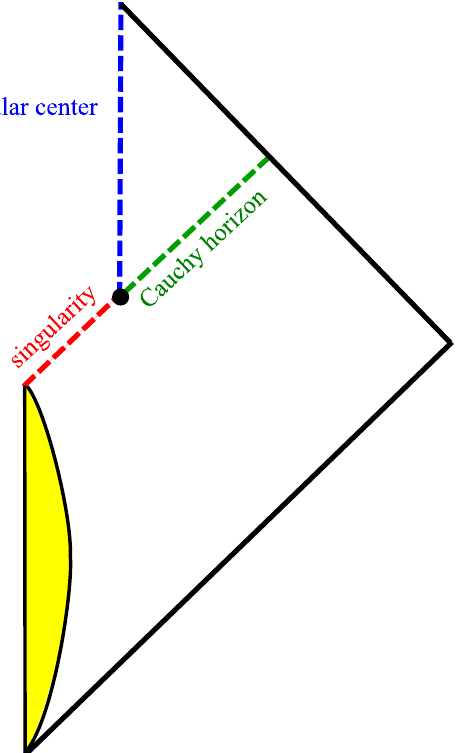
Fig. 11 Causal structure of stringy singular stars. Gravitational col- lapse (yellow colored region) of a star creates a black hole. If b is turned on at the same time, then a star-like structure is maintained, which will have a null singularity at the center. If the black hole evaporates within a finite time and approaches to a = b = 0, then after the evaporation, the center will become timelike again, while the timelike center is reg- ular. If the black hole tends towards a stable object due to the weak coupling limit, then there is no transition to a timelike center and the null singularity will be extended to